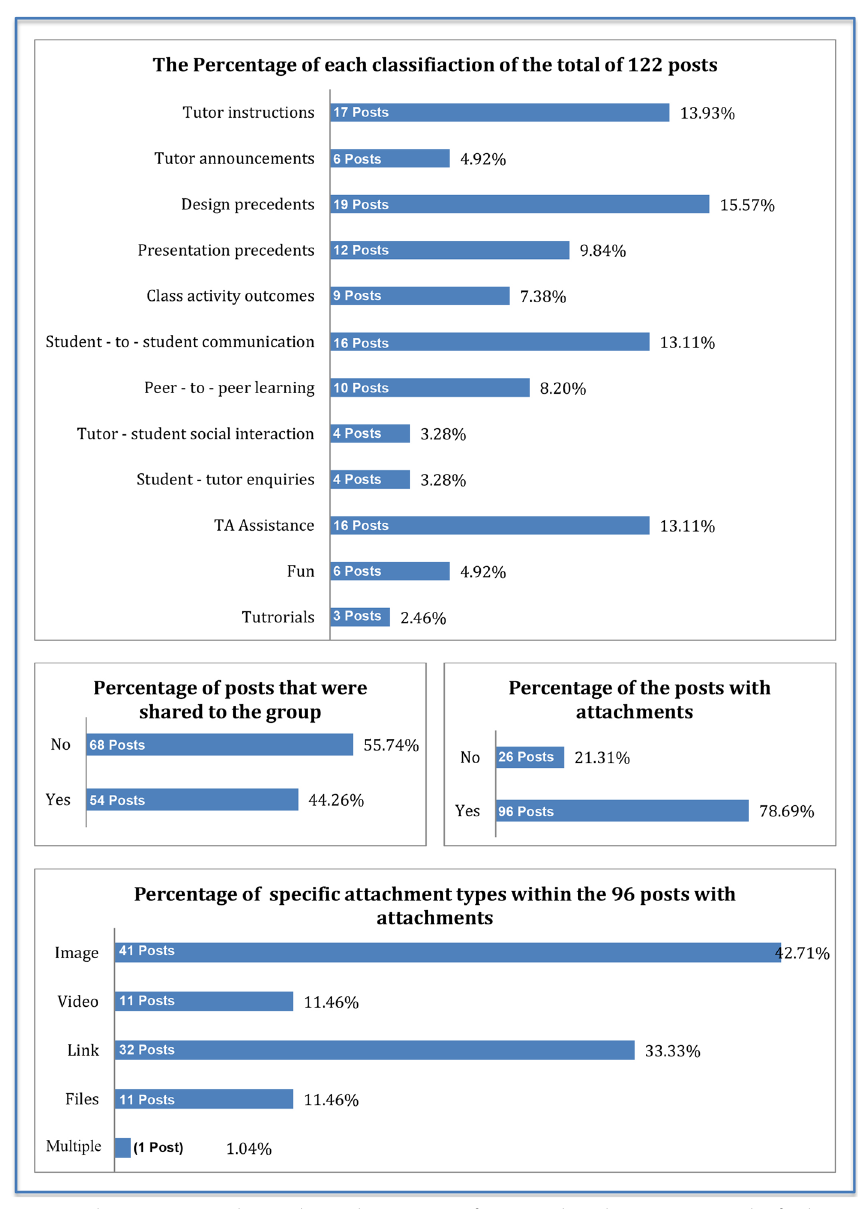
Fig. 4 Bar charts presenting the number and percentage of posts made in the group in regards of “What” was posted and “What” was the medium of the